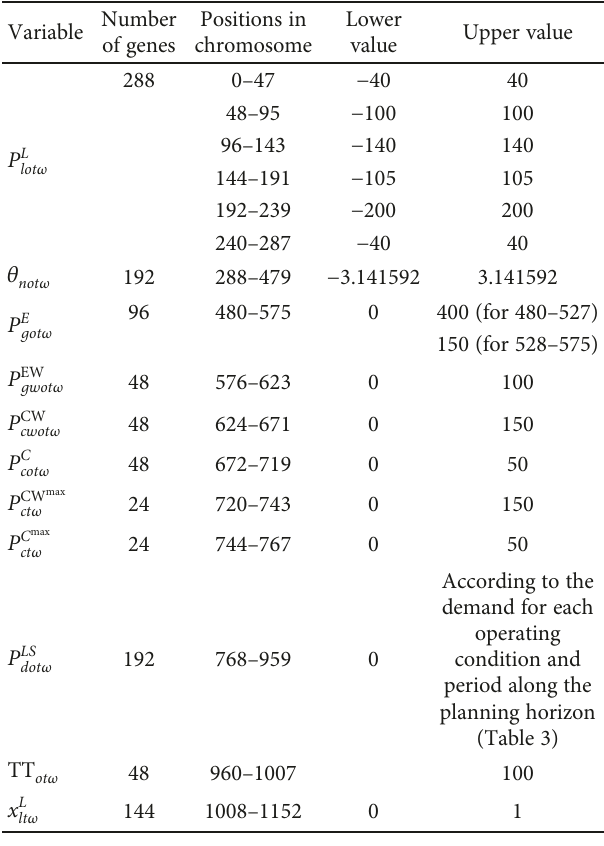
Algorithm 1: Simple genetic algorithm. Table 1: Description of a